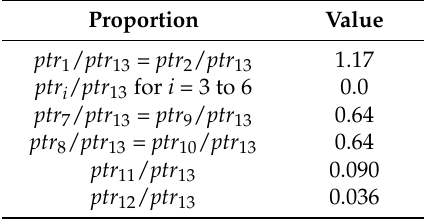
Table 2. Proportions calculated for the examined architectural free form from Figure